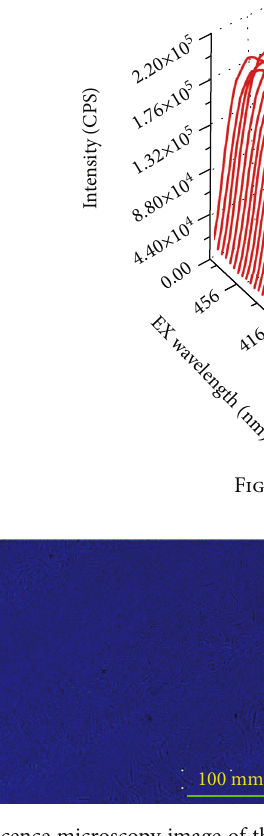
Figure 8: Fluorescence microscopy image of the